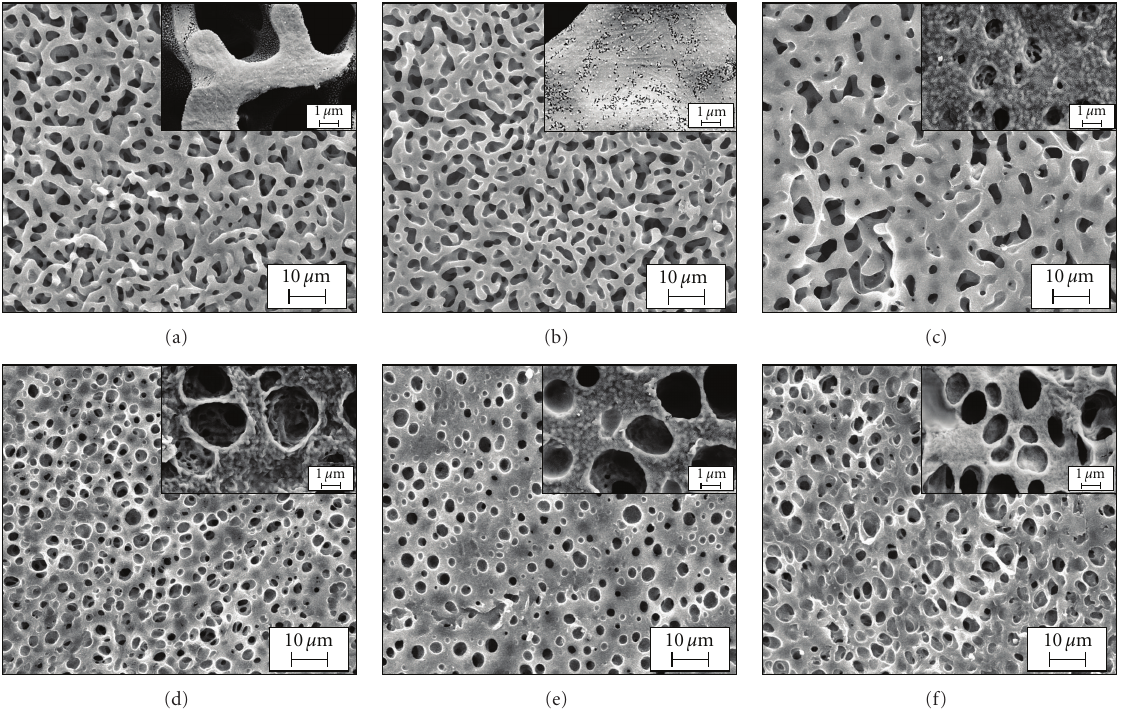
Figure 3: SEM images of polymer membranes PVDF/IL-SiO 2 (1/1). (a) the weight ratio of PVDF/IL-SiO 2 is 9/1. (b) the weight ratio of PVDF/IL-SiO 2 is 8/2. (c) the weight ratio of PVDF/IL-SiO 2 is 7/3. (d) the weight ratio of PVDF/IL-SiO 2 is 6/4. (e) the weight ratio of PVDF/IL-SiO 2 is 5/5. (f) the weight ratio of PVDF/IL- SiO 2 is